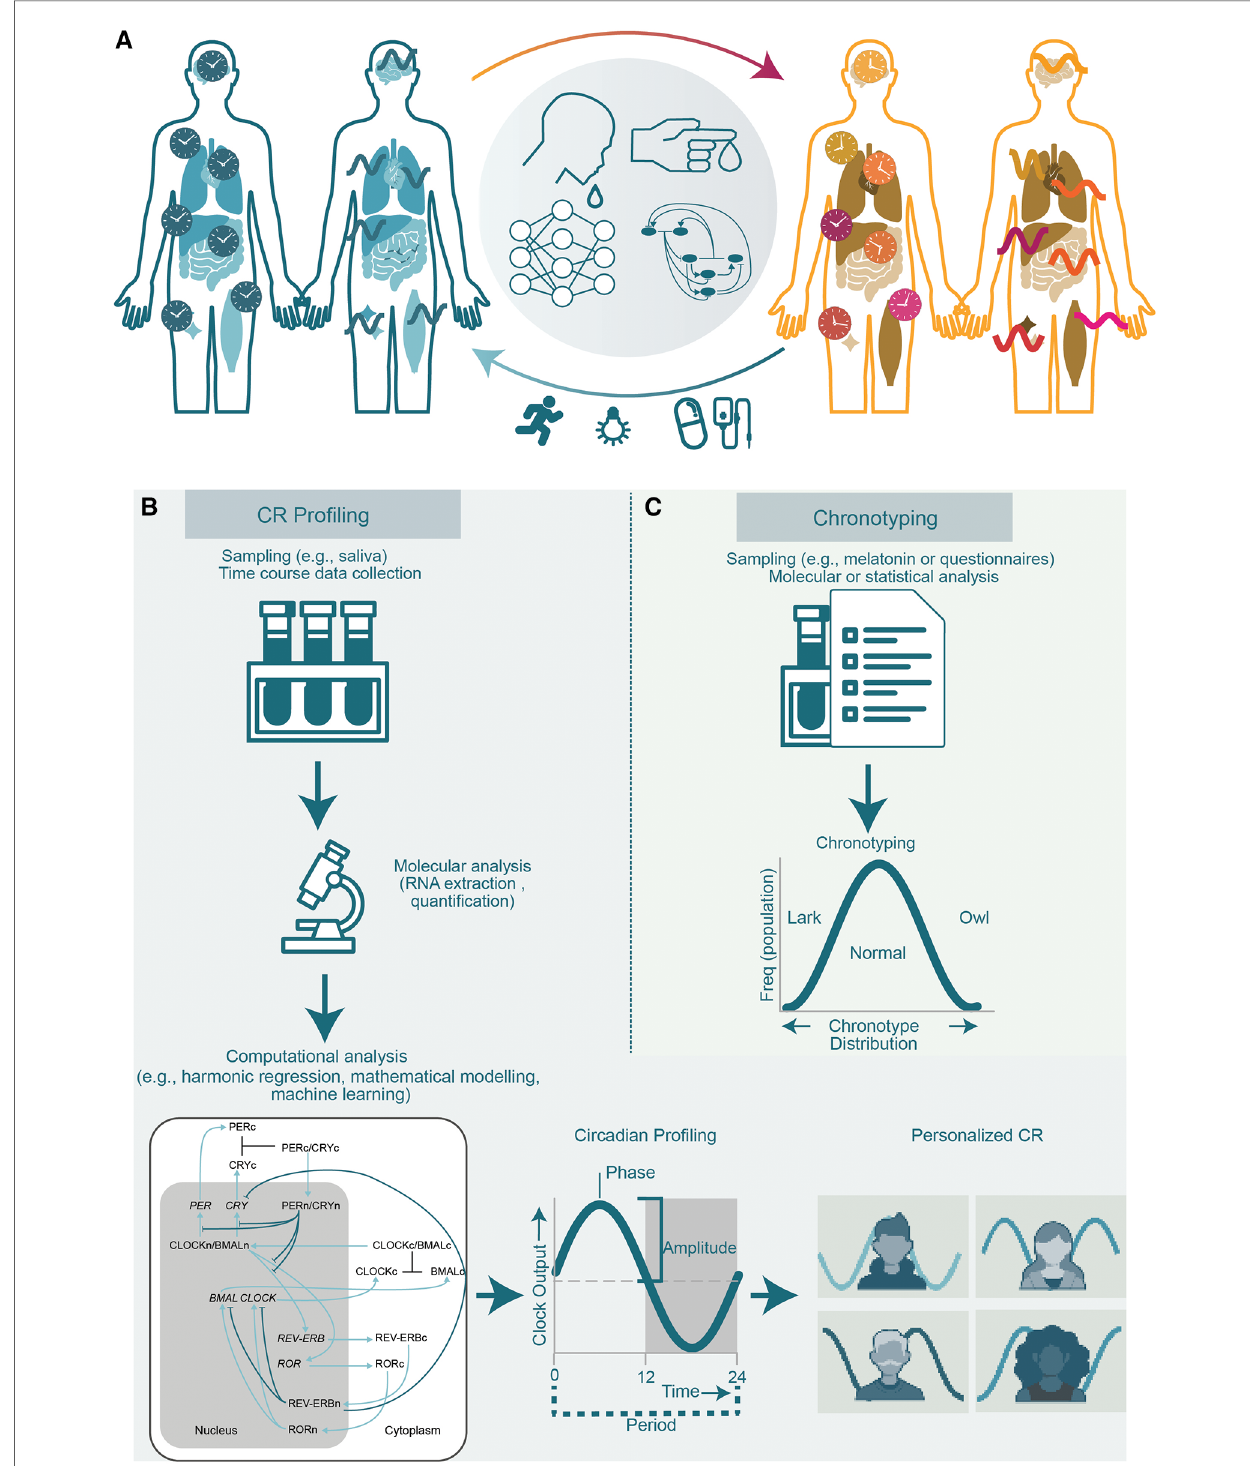
FIGURE 1 The circadian system and methods for determining CRs and chronotyping . ( A ) The role of the circadian clock in health and disease. A proper functioning clock ensures correct timing of physiological events such as sleep/wake cycles and contributes to sustain a healthy life (left). The disruption of CRs (right) is associated with numerous diseases including sleep disorders, neurodegenerative diseases, and cancer. Various circadian relevant clinical applications are being studied and implemented to diminish the negative effects of circadian disruption e.g., by the usage of zeitgebers like bright light therapy or physical exercise to reset the clock, and timely administration of drug compounds. For this purpose, methodologies (centre) using molecular data retrieved from time course collection of biological samples for e.g., from blood or saliva in combination with computational and mathematical modelling of the clock network are needed to generate a personalized pro fi le of the CR. ( B ) CR pro fi ling by repetitive and representative sampling, molecular and computational analysis to generate a personalized circadian pro fi le. ( C ) Molecular analysis of biological samples or questionnaires and correlation to populational data for typi fi cation of an individual into